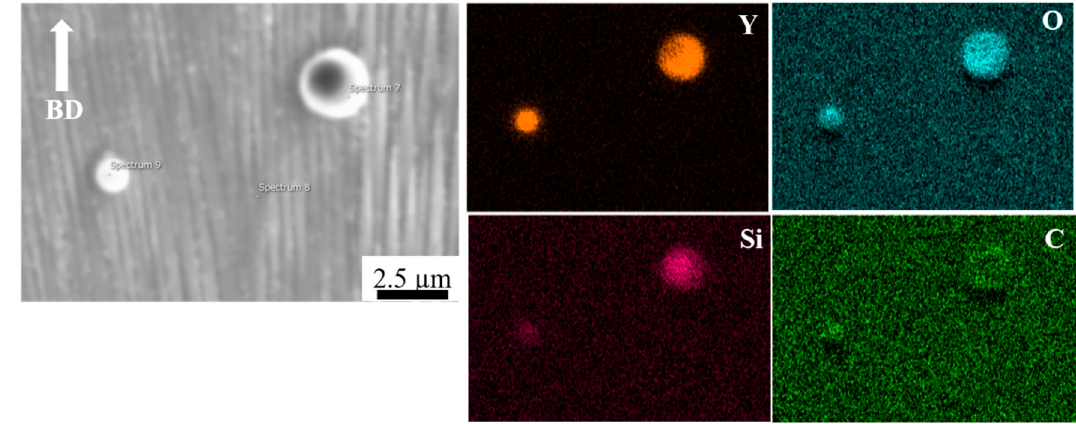
Figure 4. EDS analysis of as-built HX-a specimen in the grain.